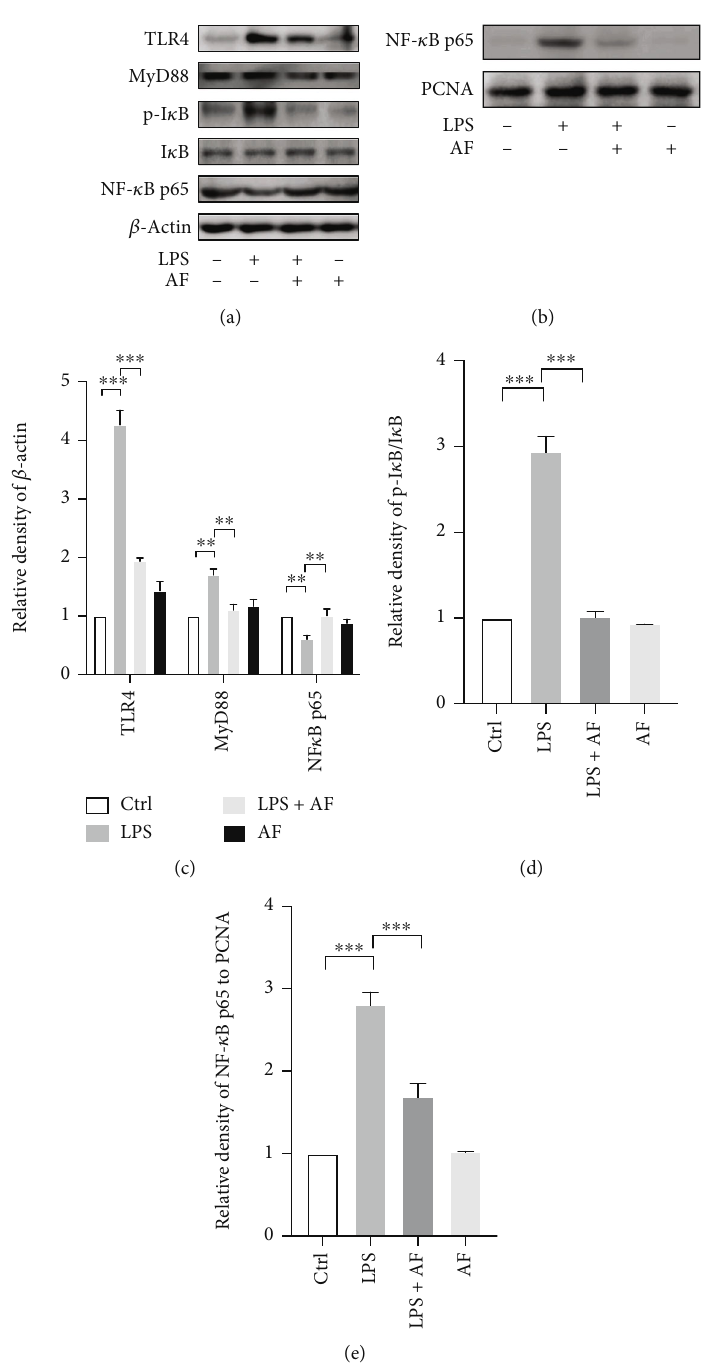
Figure 4: E ff ects of amento fl avone on regulating the TLR4/MyD88/NF- κ B axis to alter LPS-induced proin fl ammatory cytokine levels. (a) Representative immunoblots of TLR4, MyD88, p-I κ B, I κ B, and NF- κ B p65 proteins in the cytoplasm and cytomembrane in BV2 microglial cells. (b) Representative immunoblots of NF- κ B p65 proteins in the nucleus in BV2 microglial cells. (c, d)